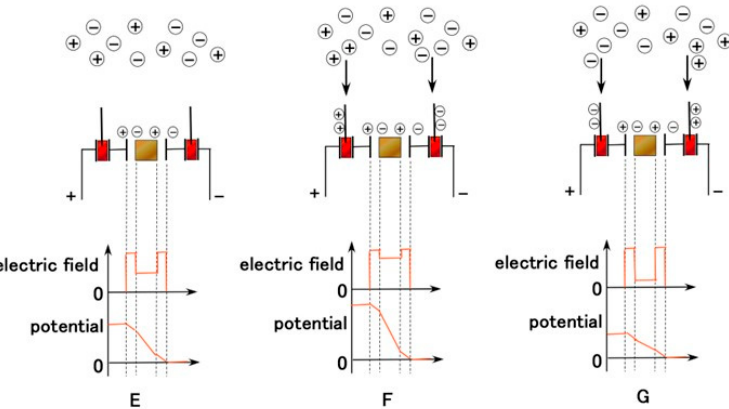
Figure 6. Physical model of electric field and potential in the equivalent electric circuit of Pacinian corpuscles.